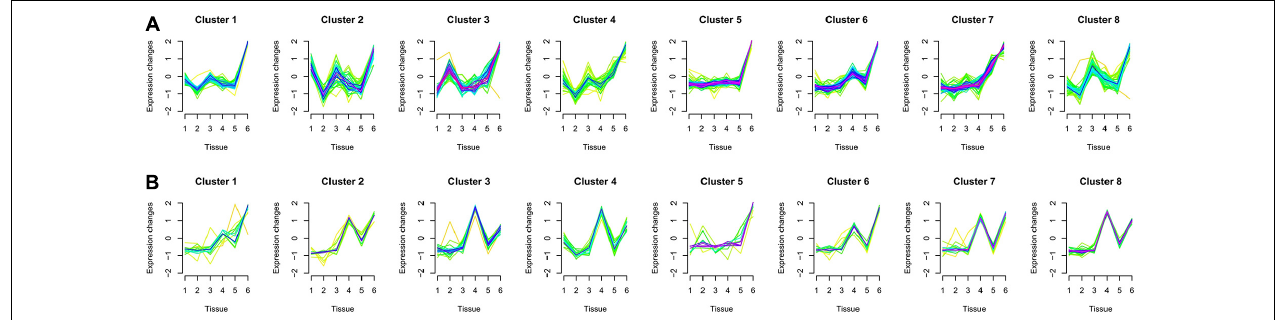
FIGURE 4 | Multitissue expression patterns of genes in key modules of lung tissue of two pig breeds. (A) Multitissue expression patterns of key module genes in Tibetan pig lung tissues. (B) Multitissue expression patterns of key module genes in Rongchang pig lung tissues. The 1, 2, 3, 4, 5, and 6 in the figure represent the muscle, liver, heart, spleen, kidneys, and lung tissues, respectively. The yellow- or green-colored lines correspond to genes with low membership value; the red- and purple-colored lines correspond to genes with high membership value.